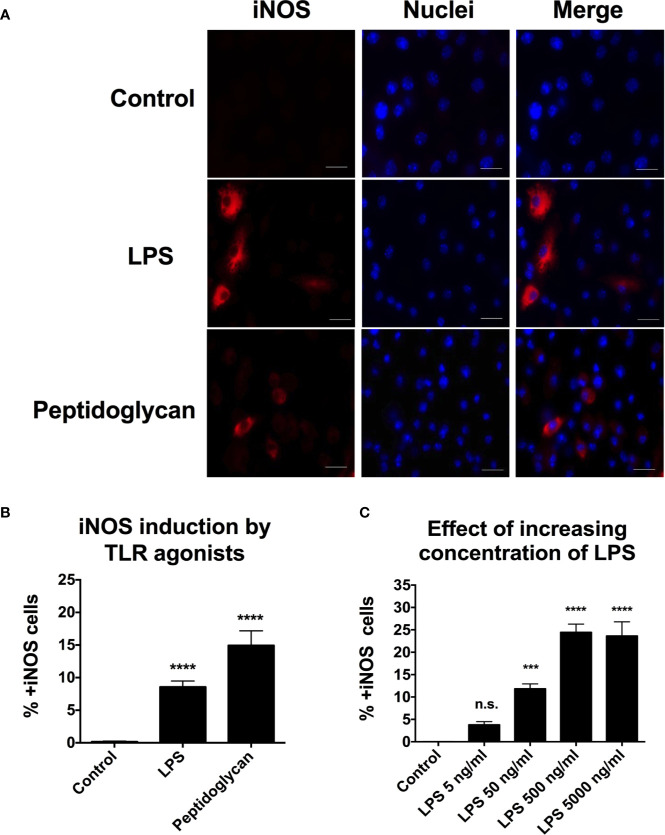
Expression of iNOS is seen after induction with LPS and peptidoglycan but the response is heterogenous throughout the population of macrophages. (A, B) RAW264.7 macrophages were incubated in the presence of the LPS (50 ng/ml) or peptidoglycan (30 μg/ml) for 16 h. (C) RAW264.7 macrophages were incubated, for 16 h, in the presence of increasing levels of LPS, 5 to 5,000 ng/ml. (A) Representative images are shown. Monolayers were fixed, and immunostained with anti-iNOS antibody to detect iNOS. Macrophage nuclei were detected with DAPI. Red-iNOS; blue-macrophage nuclei. (B, C) Cells were trypsinized, fixed, and immunostained with anti-iNOS antibody to detect iNOS activity. 100,000 cells were counted by flow cytometry. Data from three independent experiments were combined. A one-way ANOVA with Dunnett’s correction was used to determine statistical significance with ***p < 0.001 and ****p < 0.0001 and n.s, not significant. Error bars are standard error of the mean.